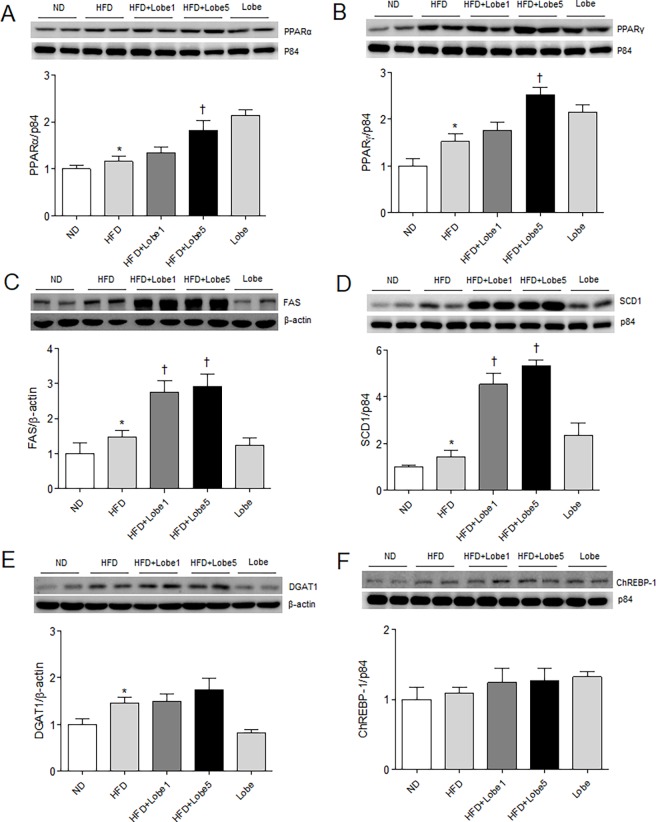
Effect of lobeglitazone (Lobe) on hepatic lipogenesis in high-fat diet (HFD)-fed mice.Western blots and quantification of hepatic (A) peroxisome proliferator-activated receptor (PPAR) α, (B) PPARγ, (C) fatty acid synthase (FAS), (D) stearoyl-CoA desaturase (SCD) 1, (E) diglyceride acyltransferase (DGAT) 1, and (F) carbohydrate response element binding protein (ChREBP)-1 expression in normal diet (ND), non-treated HFD, Lobe-treated HFD (1 or 5 mg/kg/d), and Lobe-only mice. Densitometry values for each protein are normalized to β-actin or p84. Data are presented as mean ± SEM. *P <0.05 vs. ND-fed mice; †P <0.05 vs. HFD-fed mice.